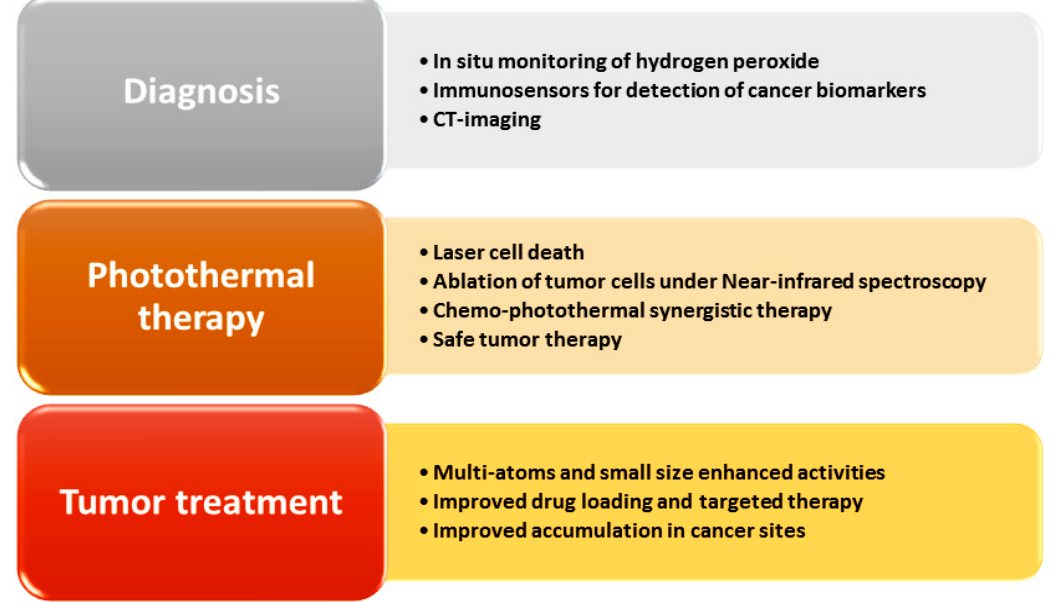
Figure 13. Anticancer potentials of trimetallic nanomaterials.